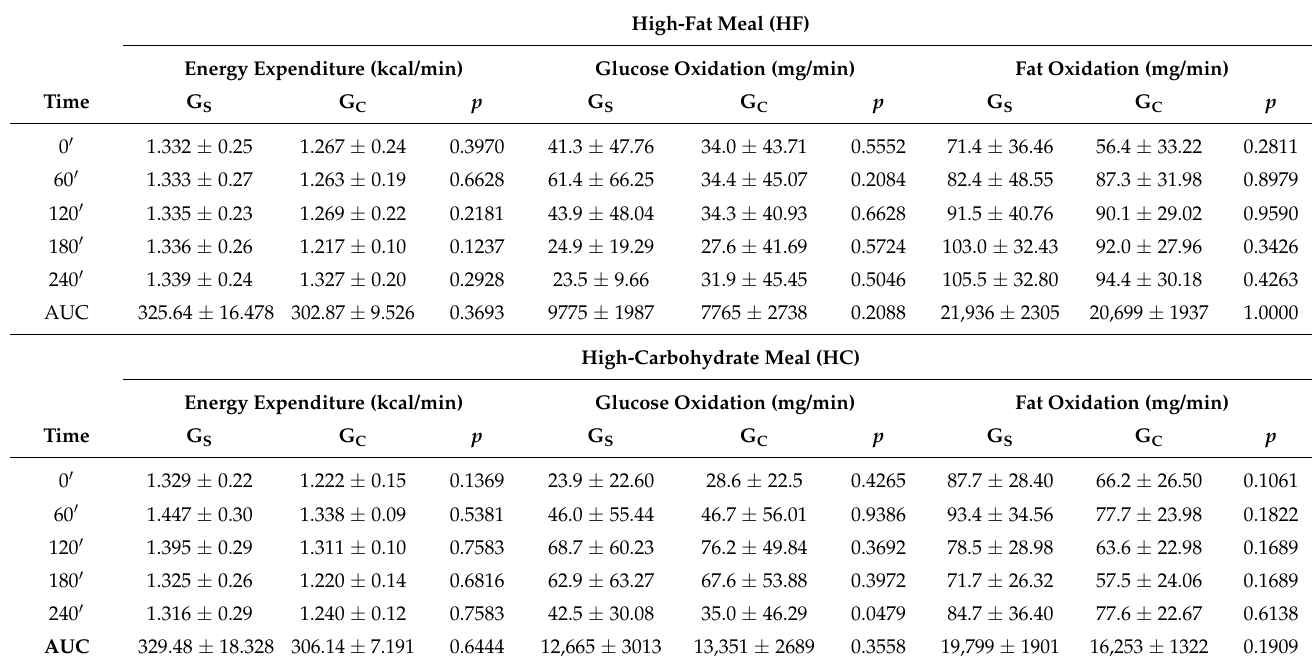
Energy expenditure (kcal/min), glucose and fat oxidation (mg/min) in G S (over- weight/obesity) group and G C (normal body weight) group on fasting (time 0 (cid:48) ) and after